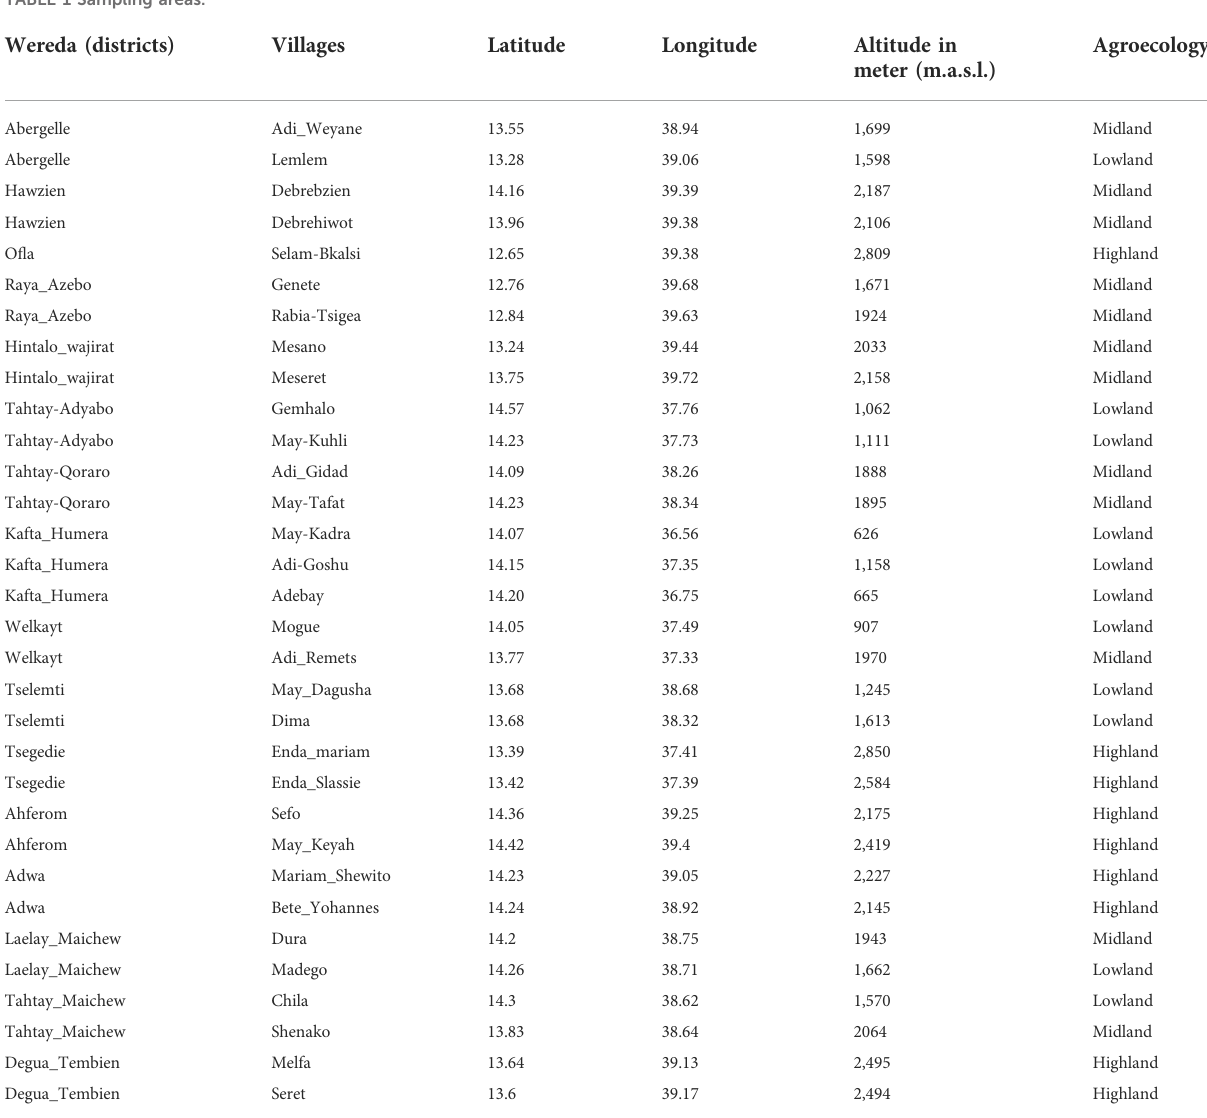
TABLE 1 Sampling